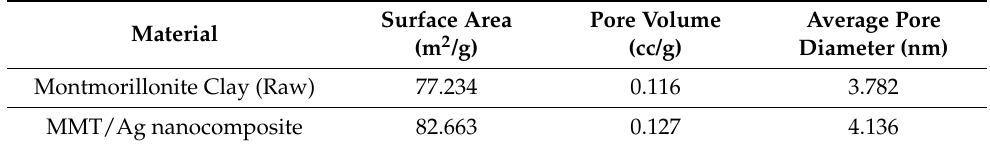
Table 1. Surface area of MMT and MMT/Ag